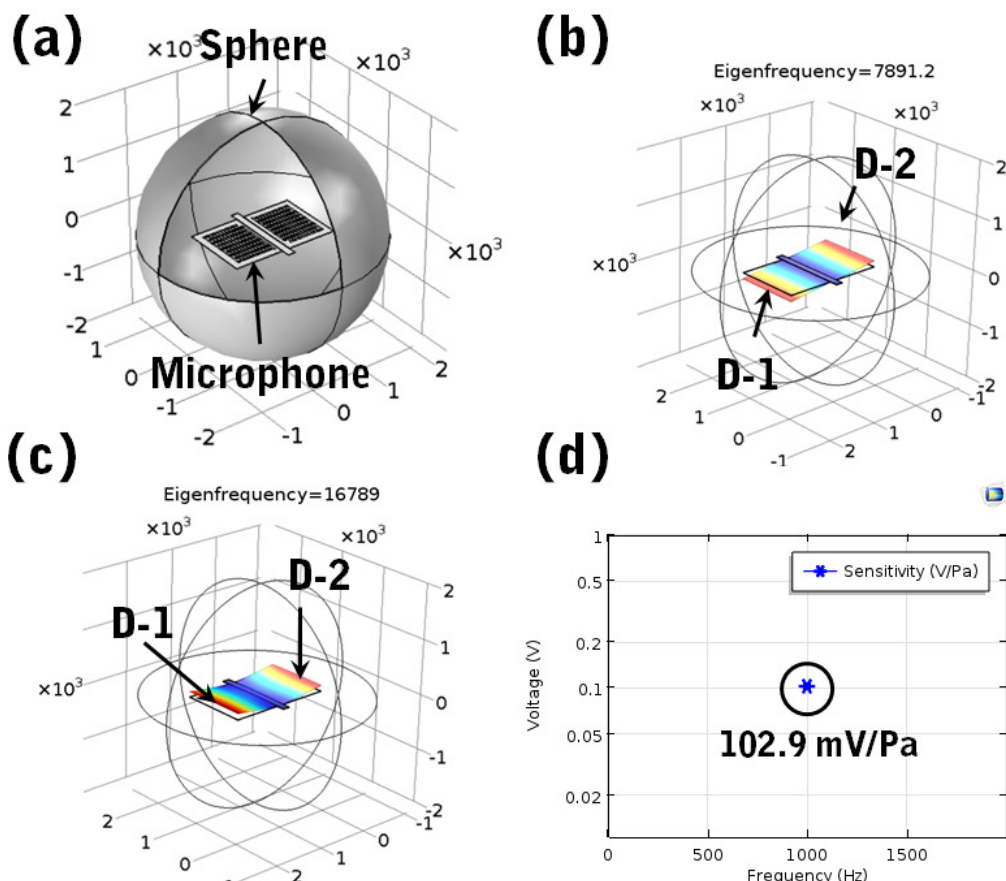
Figure 6. Device simulation, ( a ) modeling of the device in terms of the acoustic–piezoelectric interaction, ( b ) rocking mode at a frequency of 7891.2 Hz, ( c ) bending mode at a frequency of 16,789 Hz, and ( d ) sensitivity at 1 Pa of sound pressure and 1 kHz frequency.